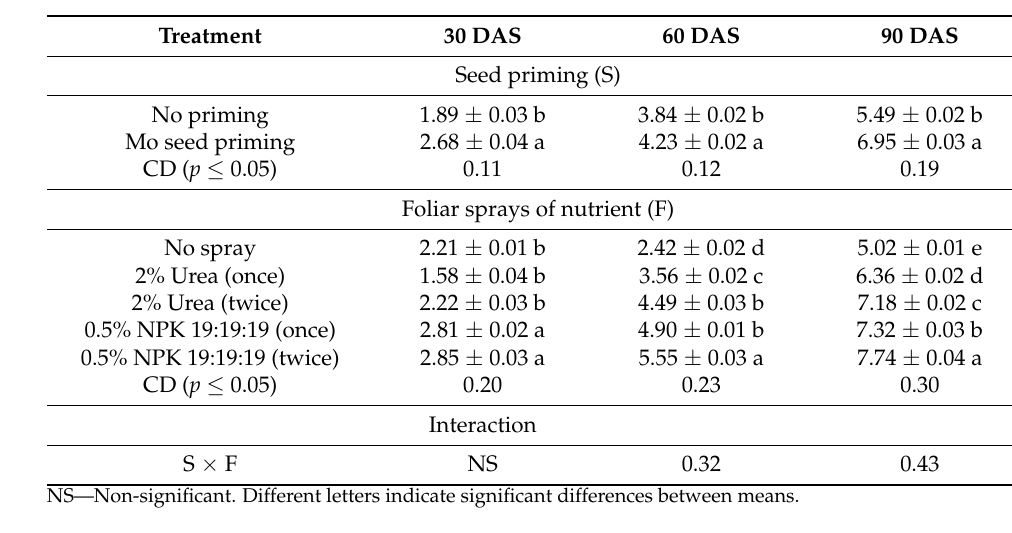
Table 5. CGR (g m − 2 day − 1 ) of grass pea at different growth stages (pooled means of 2 years).